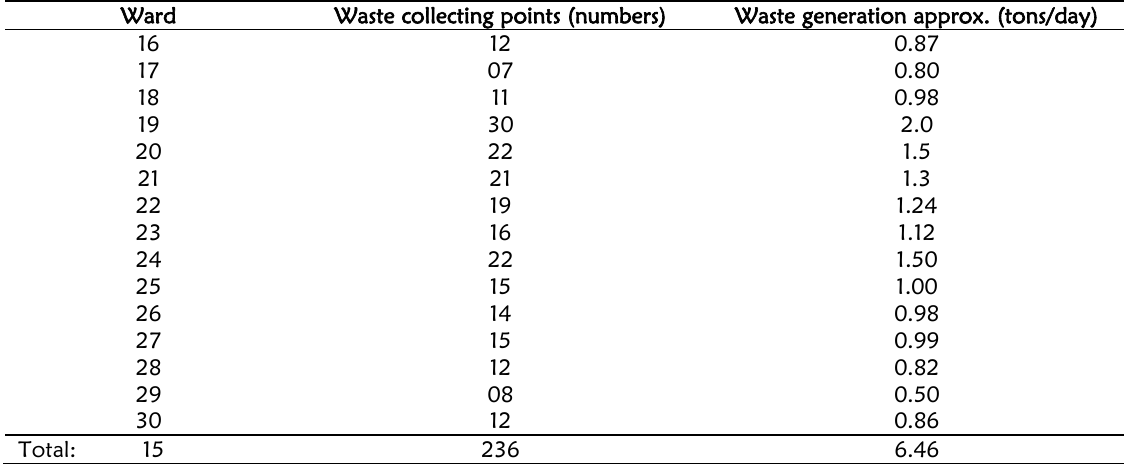
Table 5: Ward-wise daily waste generation in Rangpur city